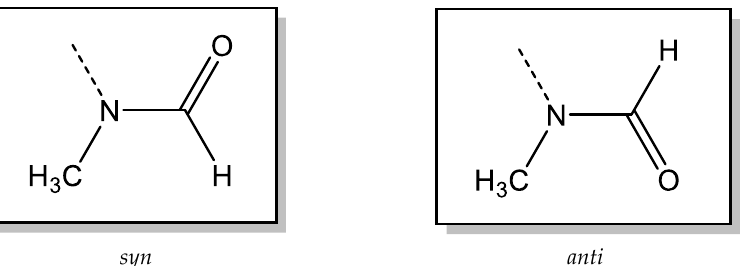
syn anti Figure 3. Orientations of the formyl group in two conformers of BHFA-NMe. The chemical bond connected to the benzhydryl group is shown by the dashed line.